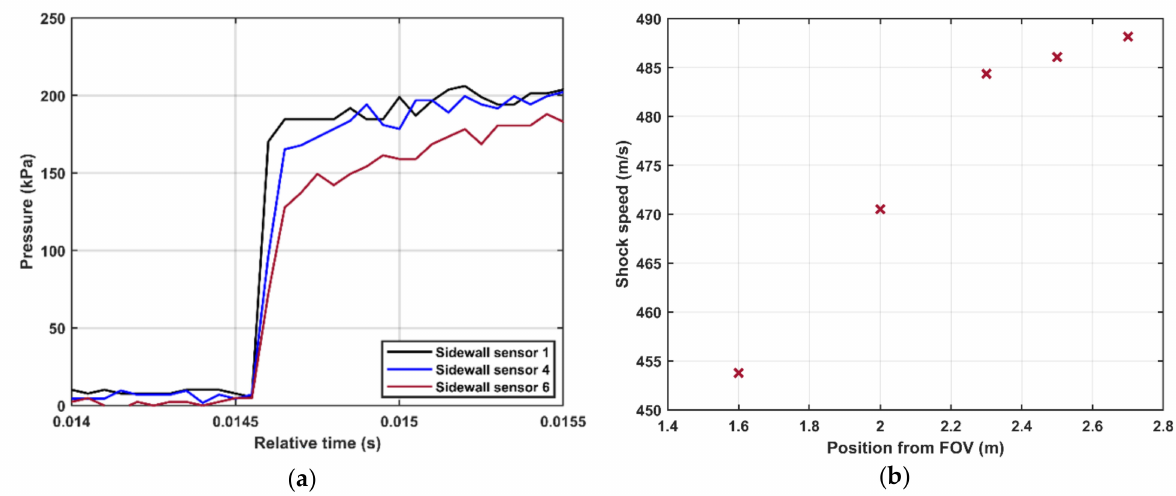
Figure 3. ( a ) The development of the incident shock front generated by the FOV at three different positions. ( b ) The shock speed at different positions from the FOV. Driven section length (L 1 ) is 3 m.